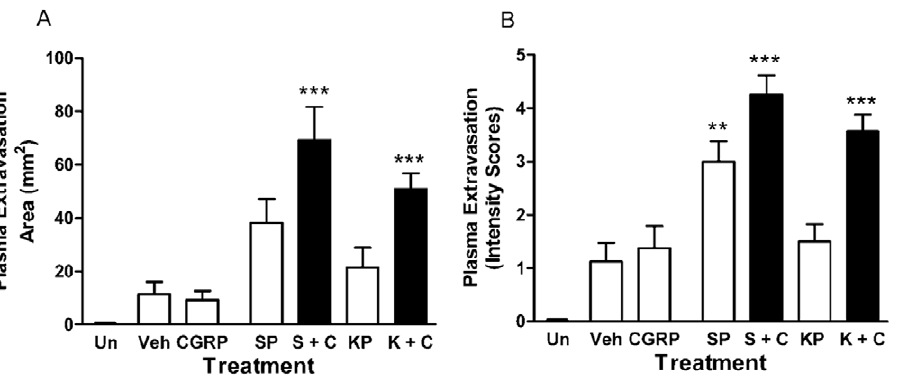
Figure 2. Kp-10 induced oedema is potentiated by CGRP. Female CD1 mice were anaesthetised, injected with Evans Blue dye i.v. and treated intradermally in the dorsal skin with 10pmol CGRP, 300pmol substance P (SP), 3nmol Kp-10 (KP), 10pmol CGRP + 3pmol SP (S + C), 3nmol Kp-10 + 10pmol CGRP (K + C) or saline control (Veh) for 30 minutes. An uninjected site was also included (Un). Plasma exudation was allowed to continue for 30 minutes post-injection, mice were killed, dorsal skin removed and the area of oedema measured (A). Lesion colour intensity was also assessed (B). Results are shown as mean area (mm 2 ) 6 SEM. N =8. *=p # 0.05, **=p # 0.01, ***=p # 0.001 assessed by one-way ANOVA compared to vehicle control.